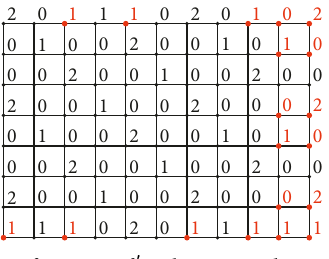
Figure 11: The function f ′ where r � 3 k + 2 , s � 3 l + 2 and r ≡ 5